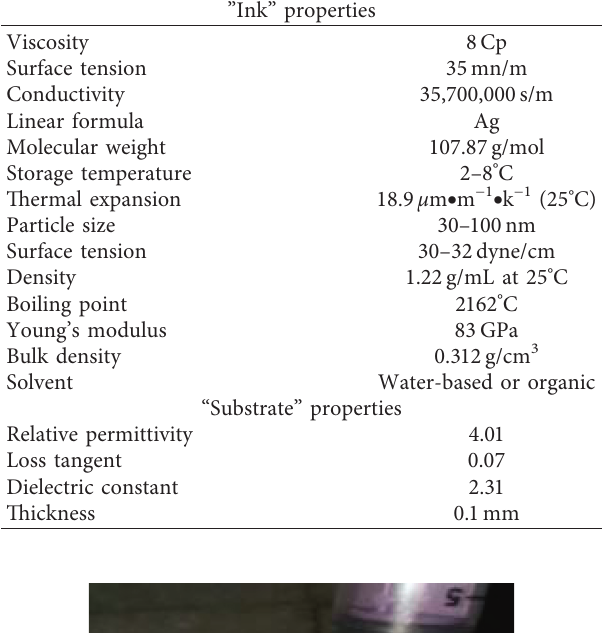
Table 1: Properties of ink and substrate.